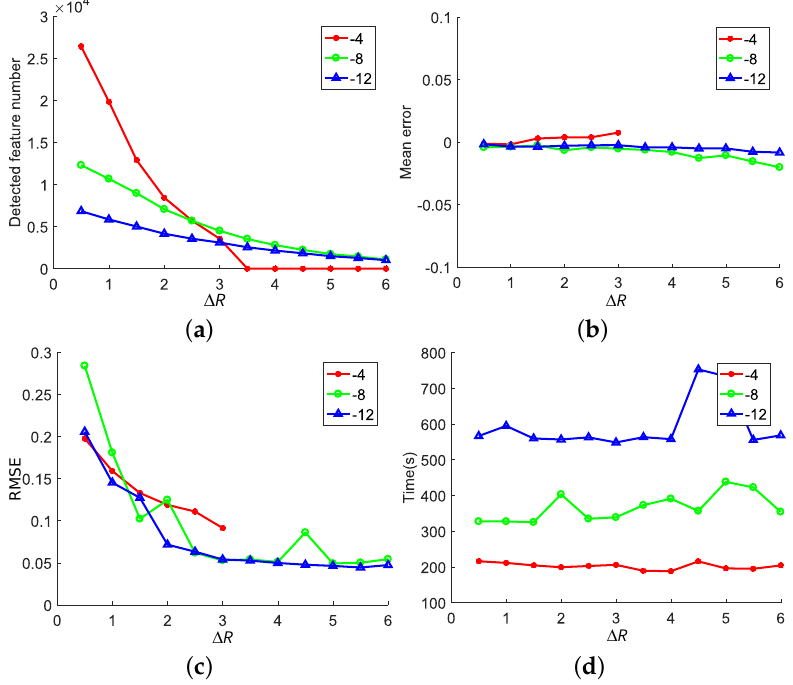
Figure 8. Detected results of proposed algorithm using 2-layer central projection stereo focal stack (CPSFS) on simulated raw images. ( a ) The number of the detected features. ( b ) Mean error of detected features’ plenoptic disc radius (dimensionless). ( c ) Root mean square error (RMSE) of detected features’ plenoptic disc radius (dimensionless). ( d ) Total detection time of 20 independent